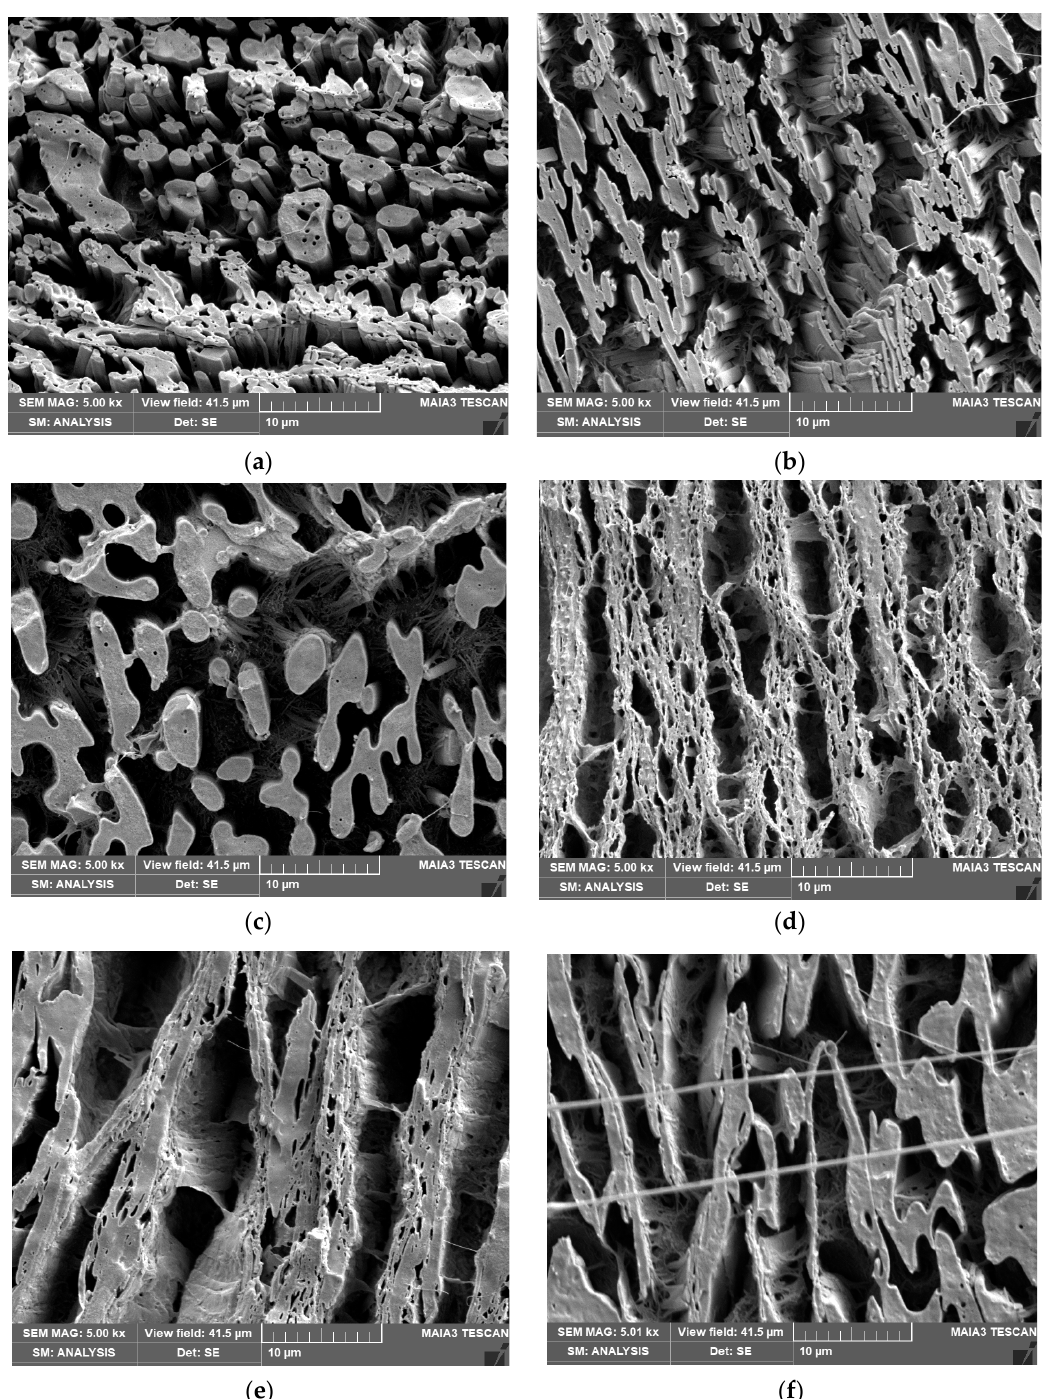
Figure 3. SEM images of 60/40 systems: ( a ) neat blend with DMF treated PLA; ( b ) DMF-treated PCL; NC with ( c ) PLA/CNC masterbatch, ( d ) PCL/CNC masterbatch, ( e ) PLA/CNCd masterbatch, and ( f ) PCL/CNCd masterbatch; the dark area represents the NaOH-removed PLA phase. A structure of the unetched sample ( c ) is shown in Figure S1c.